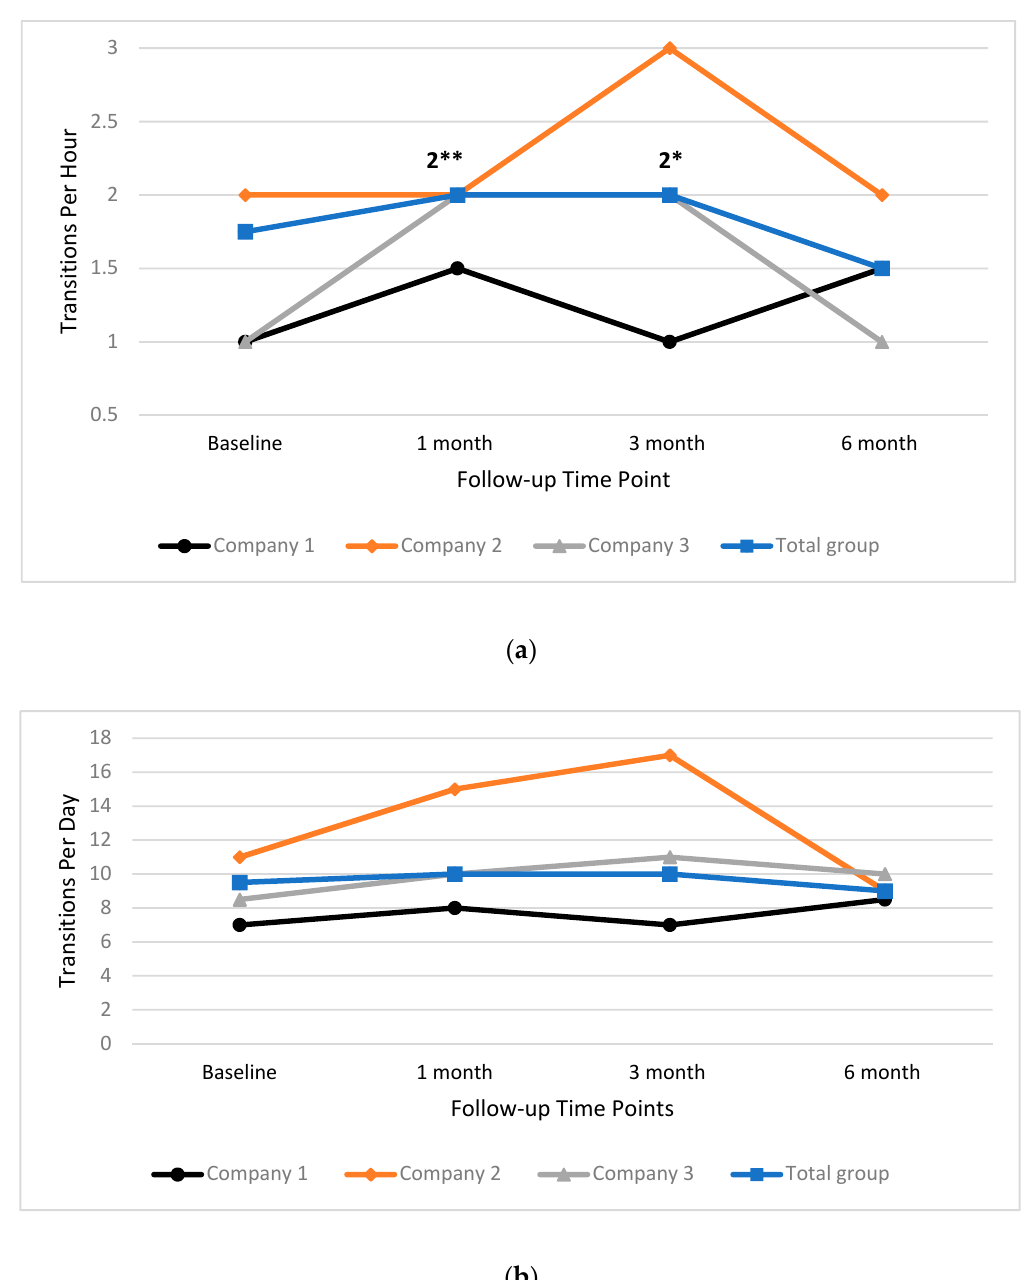
Figure 5. Median transitions per hour ( a ) and day ( b ) for total group and individual companies at baseline, one month, three month and six month time points. ** = significant change, * = trend towards significant